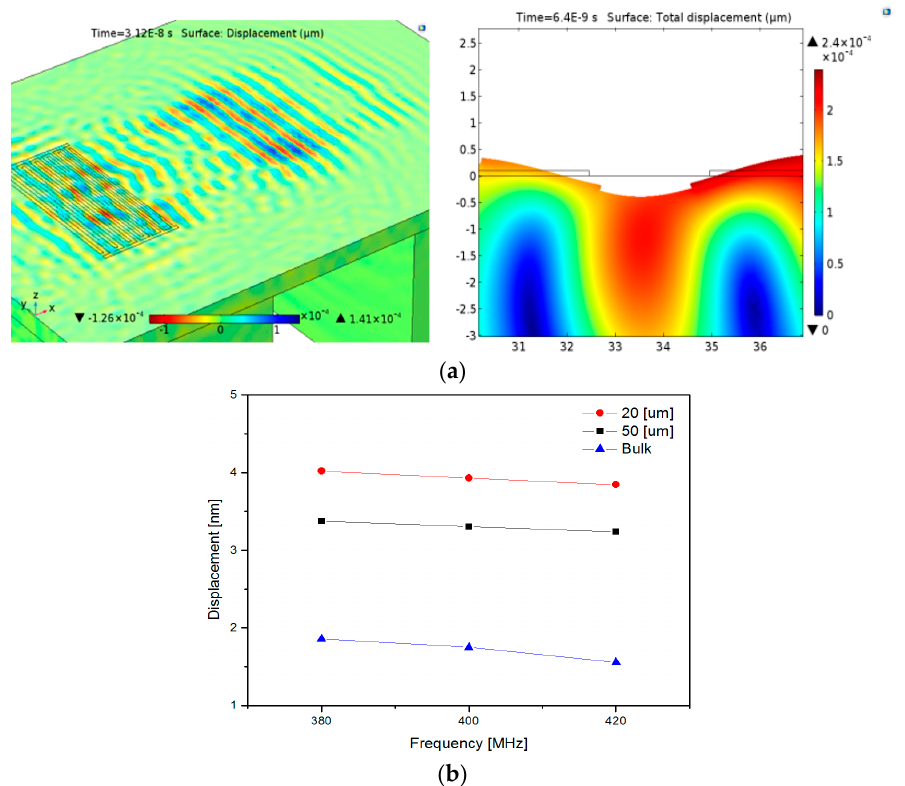
Figure 2. ( a ) Simulated AO unit using COMSOL and ( b ) surface displacement in terms of waveguide thickness and frequency.